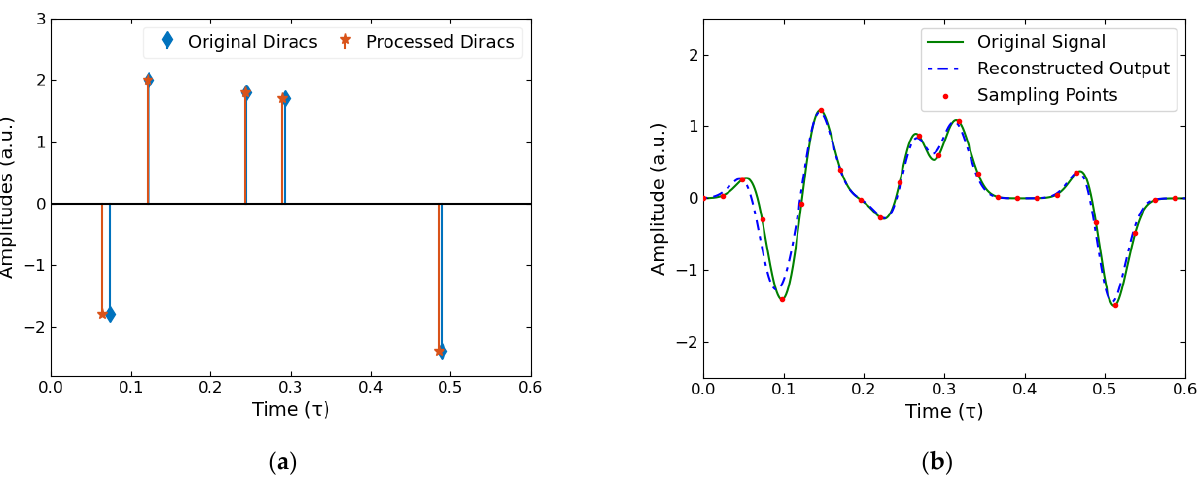
Figure 2. Noiseless simulated results. ( a ) The blue peaks represent the simulated THz pulses’ time locations and amplitudes with the orange Diracs being the FRI method processed results. ( b ) The simulated signal (green line) was sampled (red points) to input into the FRI code. The reconstructed signal (dashed blue line) was calculated using the calculated time locations and amplitudes shown in ( a ) along with the known sampling kernel.